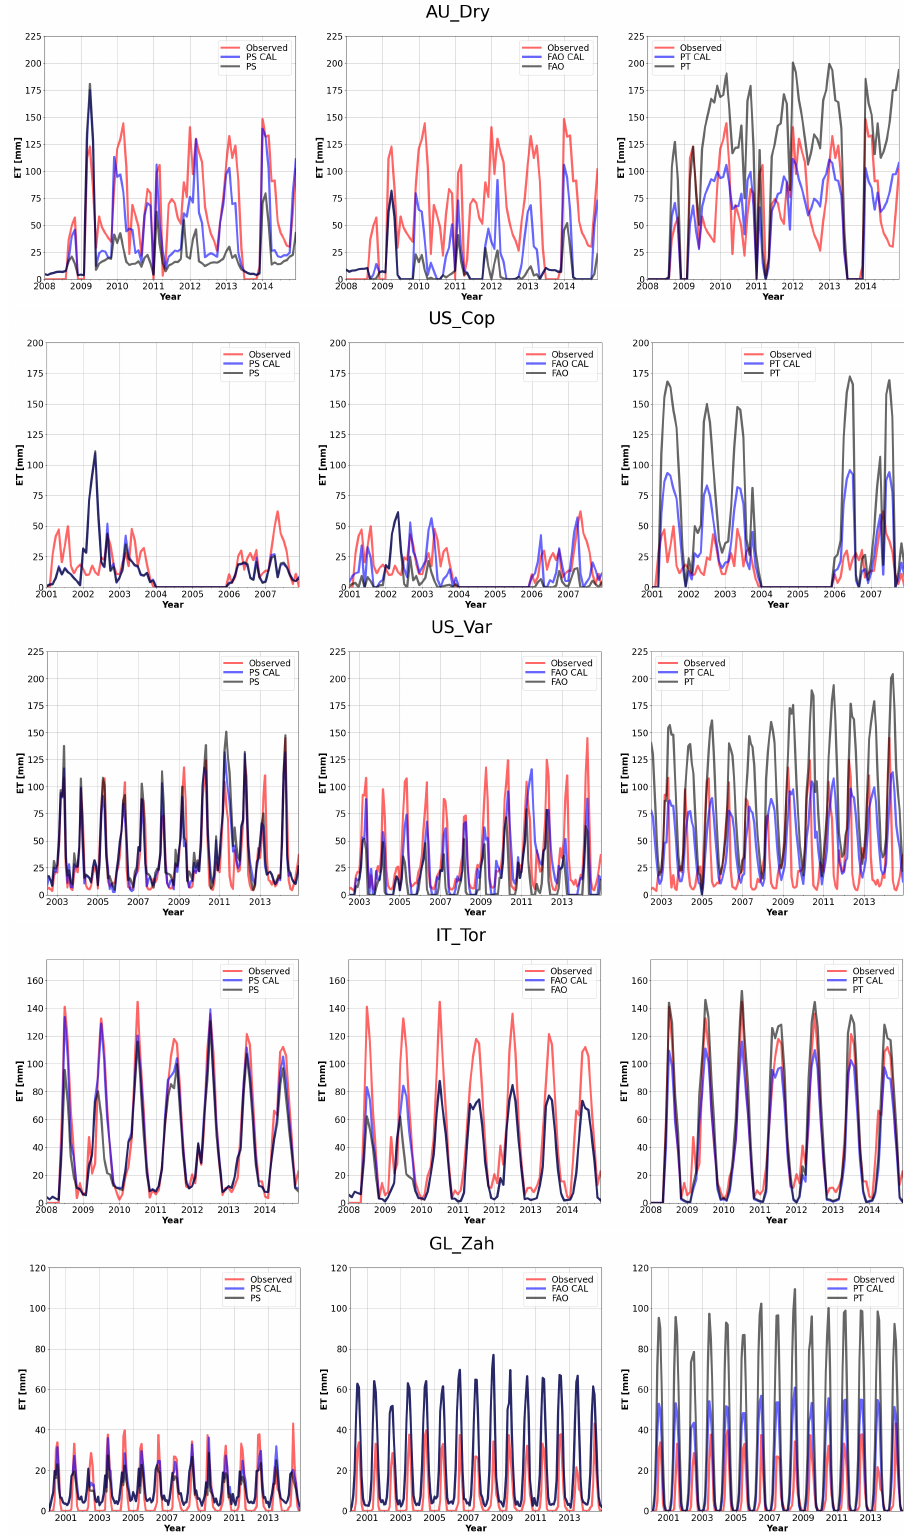
Figure 5. Time variation of the measured (red line) and simulated ET, both using uncalibrated parameter (black line) and calibrated parameters (blu